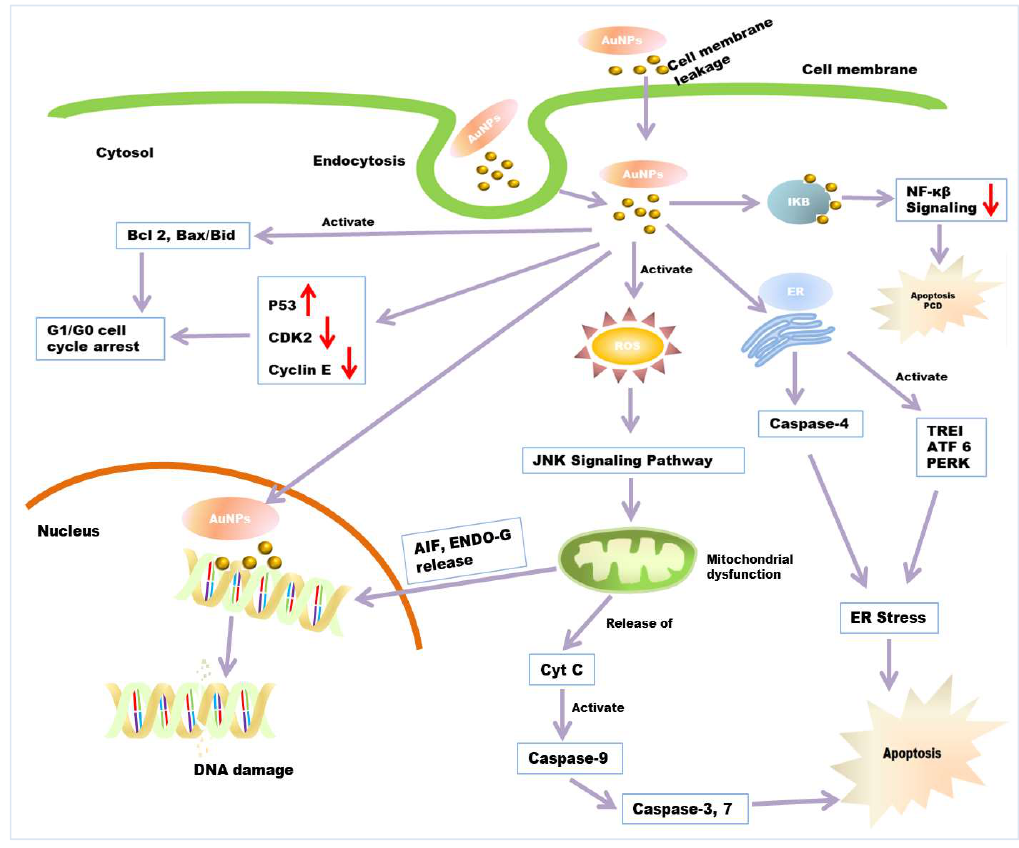
Figure 4. Anticancer mechanism of AuNPs. Entry of AuNPs into the cell’s endocytosis or cellular internalization through a lipid bilayer. AuNPs induce the apoptosis of cancerous cells through ROS-mediated mitochondrial dysfunction and caspase activation. AuNPs causes ER stress through the activation of caspase 4 and stress-related proteins, which also results in apoptosis. Damaged mitochondria release AIF, ENDO-G into the nucleus, which causes the final execution of cell death. AuNPs increases the expression of P53 and decreases the expression of CDK2, Cyclin E. It also elevates the expression of apoptotic gene bid, bax/bcl2, which ultimately leads to G0/G1 phase cell-cycle arrest. AuNP induces PCD and apoptosis through the interfering NF-κB signalling pathway.